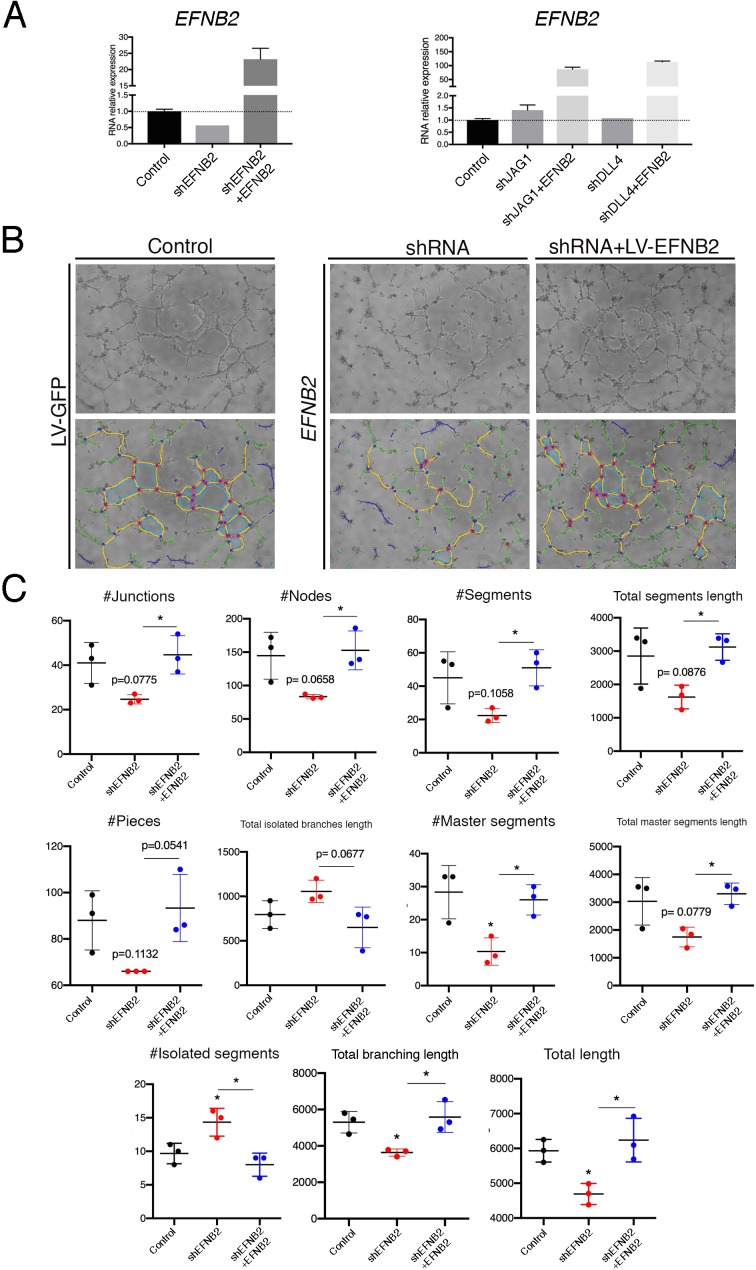
EPHRINB2 rescues defective capillary network formation after shRNA-mediated silencing of EFNB2.(A) qRT-PCR of expression of EFNB2 after transduction of indicated shRNA. (B) Representative phase contrast images (1 of 2 experiments) of the HUVEC network, after transduction of indicated shRNA and rescue by EFNB2 analyzed by the Angiogenesis Analyzer fromImageJ. (C) Informative measurements in the analyzed area: nodes surrounded by junctions (red dot surrounded by dark blue circle). Isolated elements (dark blue line). Segments (yellow). Total segments length: sum of length of the segments. Number of pieces: sum of number of segments, isolated elements and branches detected. Total isolated branches length: sum of the length of the isolated elements. Red asterisks refer to comparisons between experimental and control situations. Black asterisks refer to comparisons between shRNA-mediated inhibition and LV-mediated rescue. Data are means ± s.d. ****p<0.0001; ***p<0.001; **p<0.01; *p<0.05, by ANOVA.